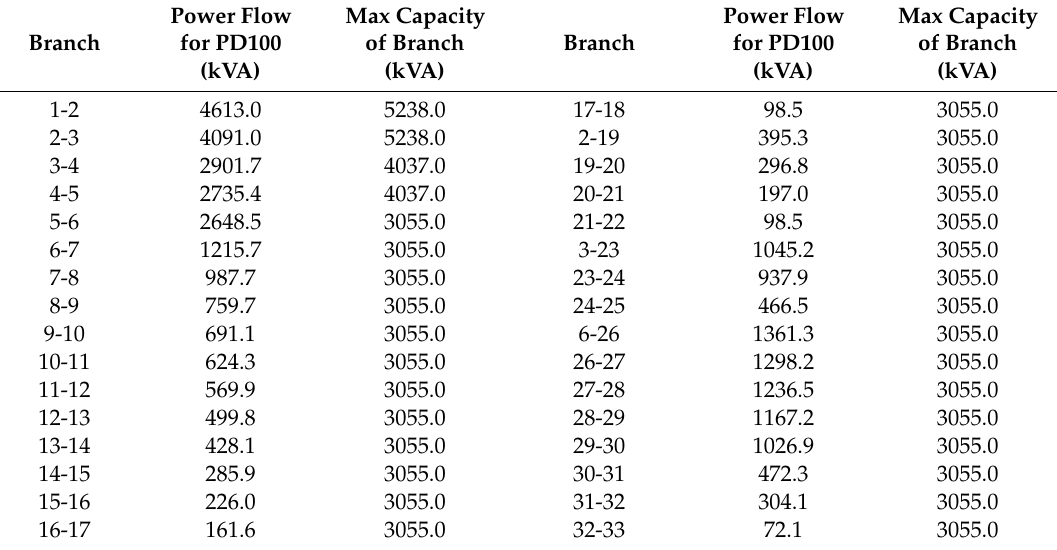
Table 7. Maximum capacity of the feeders calculated based on the PD100